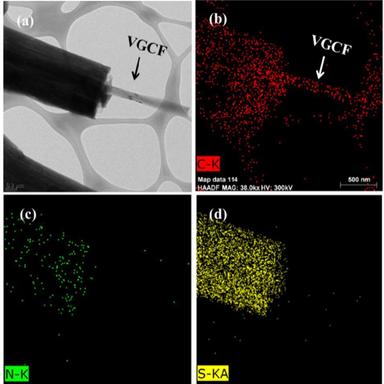
(a) STEM image and (b–d) EDS mapping of SVF composite.